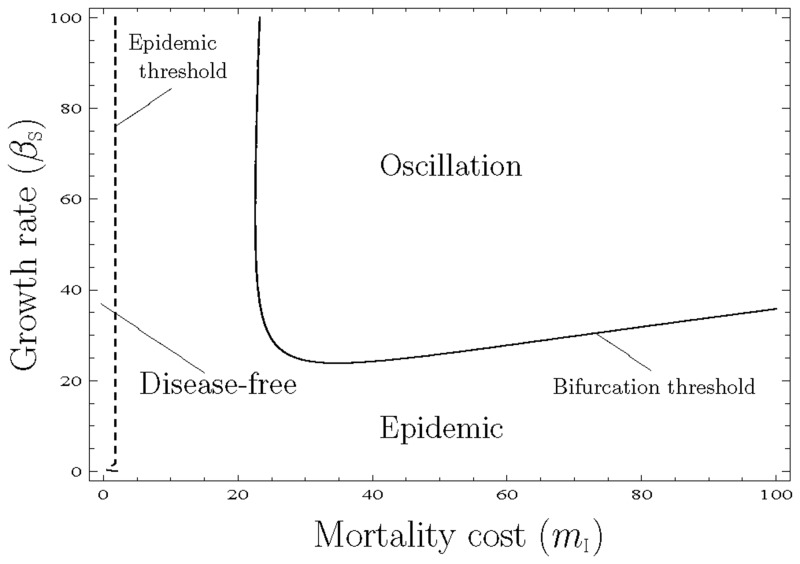
Phase diagram of pair approximation showing the three regions of the equilibrium state.In the epidemic region, plants and pathogens coexist and the equilibrium is stable. In the oscillation region, plants and pathogens coexist, but the equilibrium is unstable. Therefore, Hopf bifurcation occurs and oscillation is observed. The solid line indicates the bifurcation threshold, and the dashed line the epidemic threshold, respectively. In the disease-free region, pathogens become extinct because of the too low mortality cost.